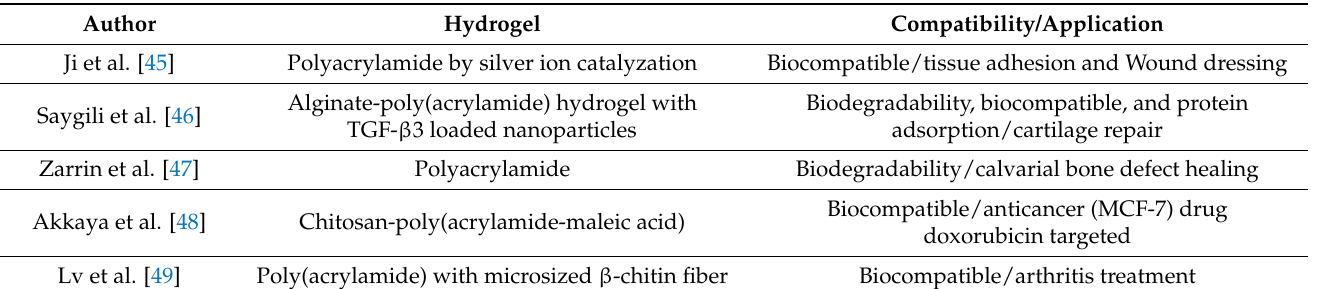
Table 1. Summary of the different hydrogels used for biomedical